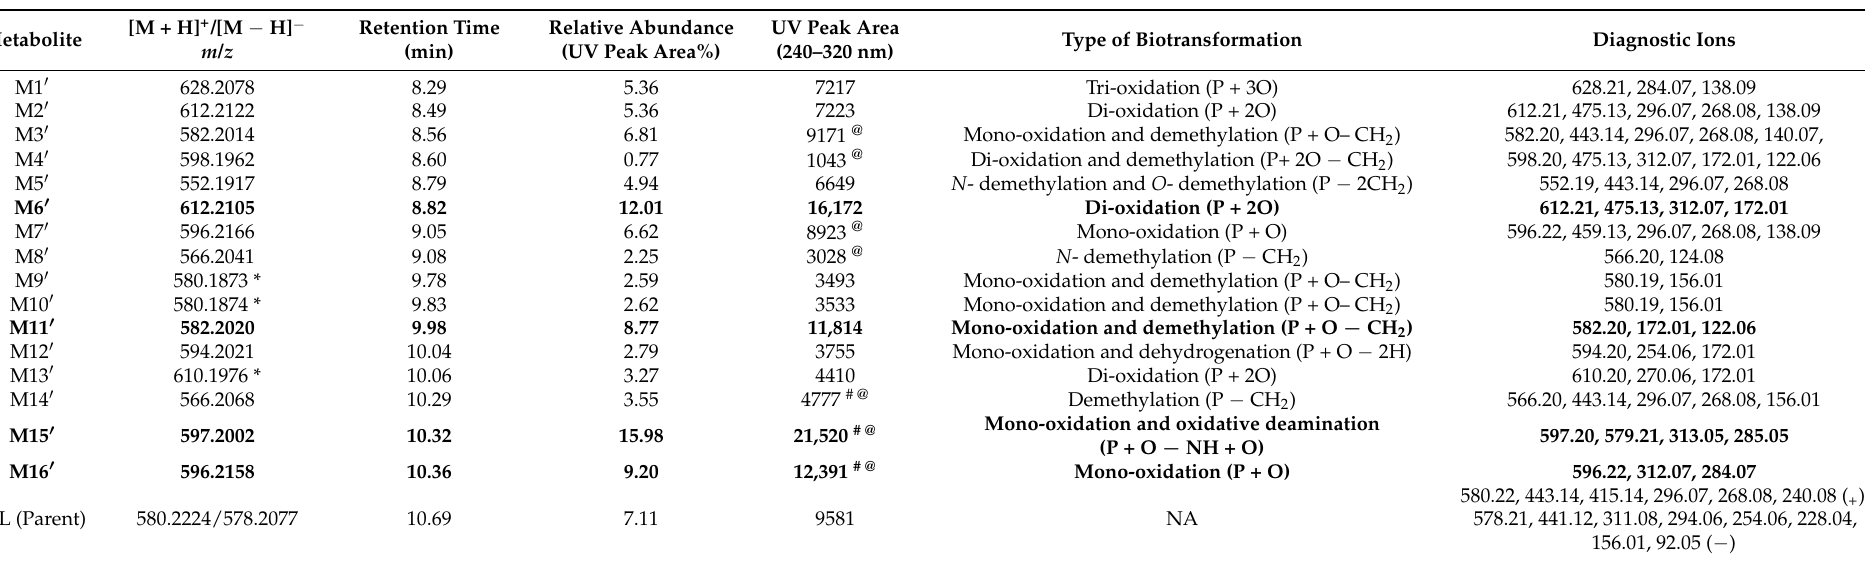
Table 3. List of putative metabolites of 11L with the primary identification parameters and hypothesized biotransformation. The relatively most intense metabolites are in